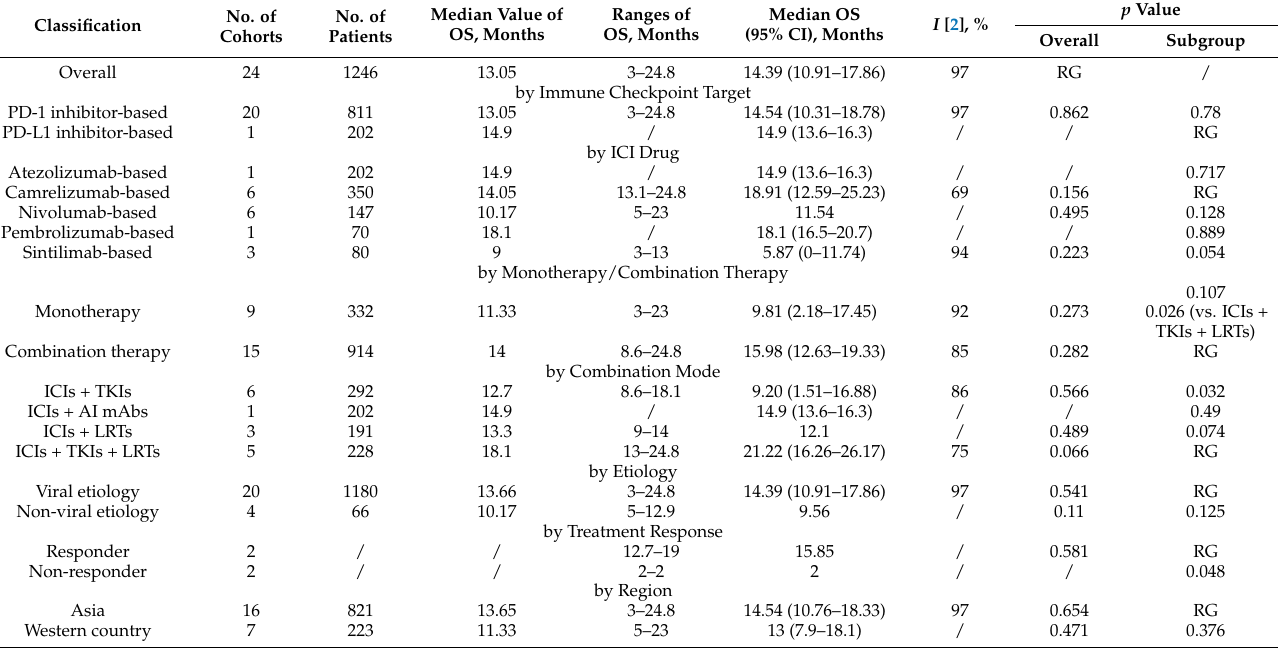
Table 2. Subgroup analysis of OS in advanced HCC patients receiving first-line ICIs-based therapy.